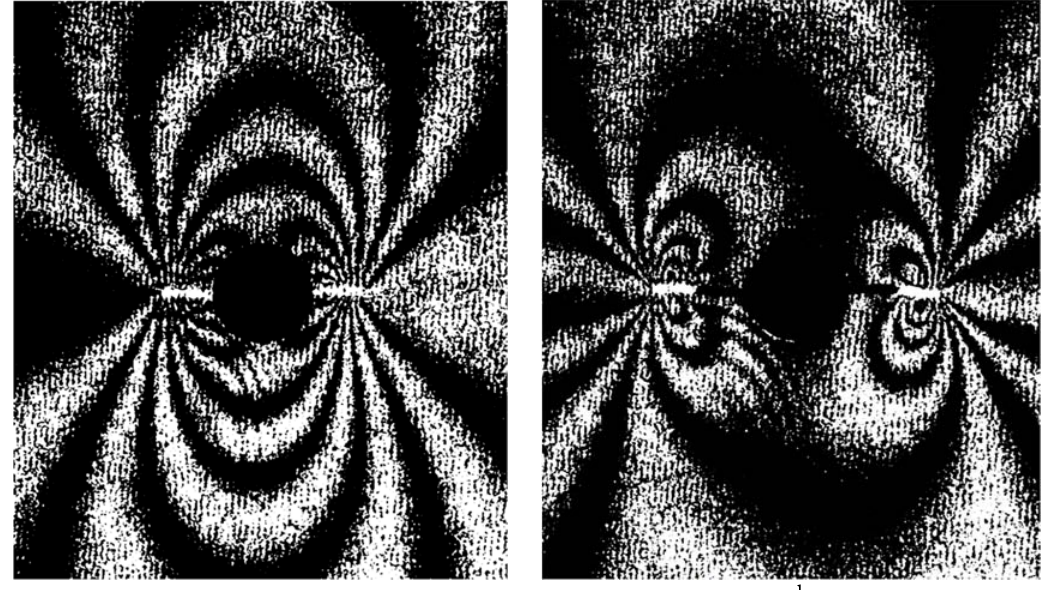
a b Figure 3: Interference fringe patterns obtained in terms of in-plane displacement component v for specimen T5_16H.a – initial crack length 0 a = 0 with the increment   1 a = 2.17 mm (left) and   1 a = 2.10 mm (right); b – initial crack length  1 a = 2.17 mm with the increment   2 a = 1.89 mm (left) and initial crack length  1 a = 2.10 mm with the increment   2 a = 1.82 mm